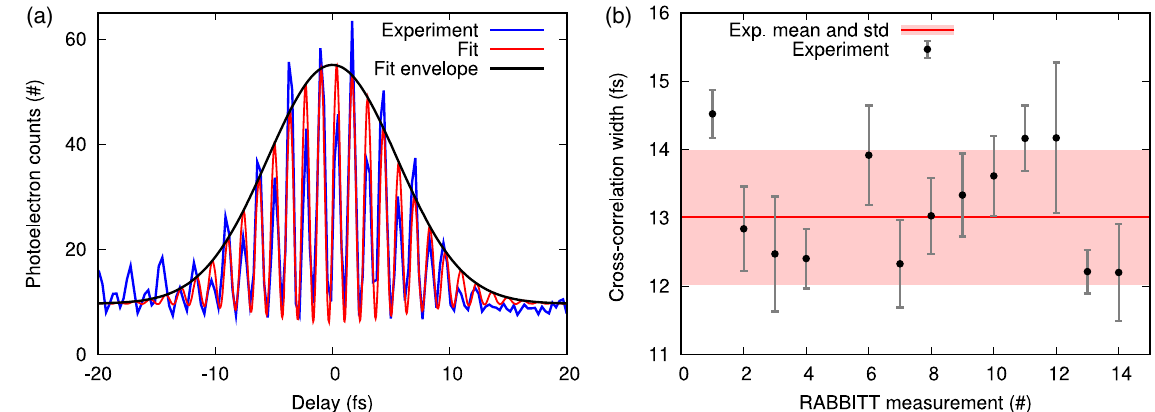
FIG. 6. (a) Fit of sideband oscillations from a RABBITT measurement. From the FWHM of the fit, the cross-correlation width is determined. The blue line shows the measured oscillations of an individual sideband of a RABBITT measurement, the red line shows the fitted function, and the black line shows the fitted Gaussian envelope. (b) Cross-correlation widths and their standard errors from the individual RABBITT measurements. The average cross-correlation width (red line) and its standard deviation (red area) are 13 (cid:2) 1